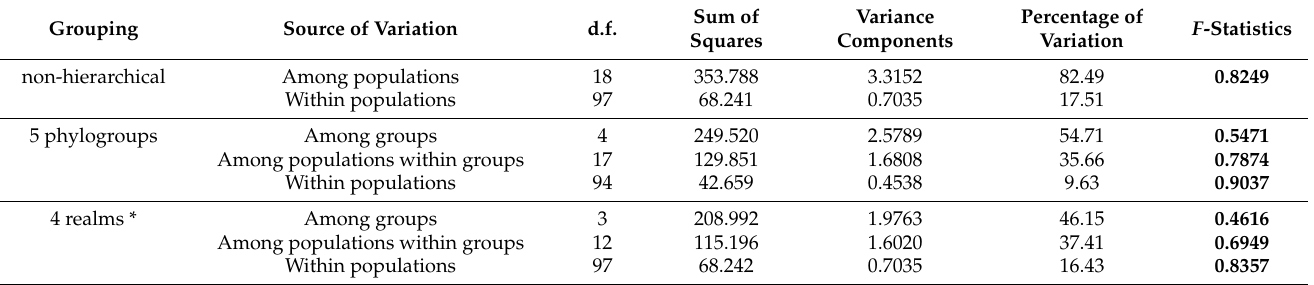
Table 3. Analyses of molecular variance (AMOVA) of mitochondrial COI-5P